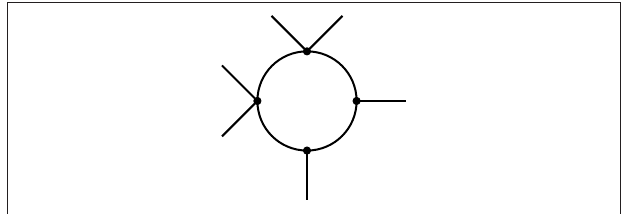
FIGURE 7 | Non-genuine 1-loop topology T31 for operator O ′ 1 .